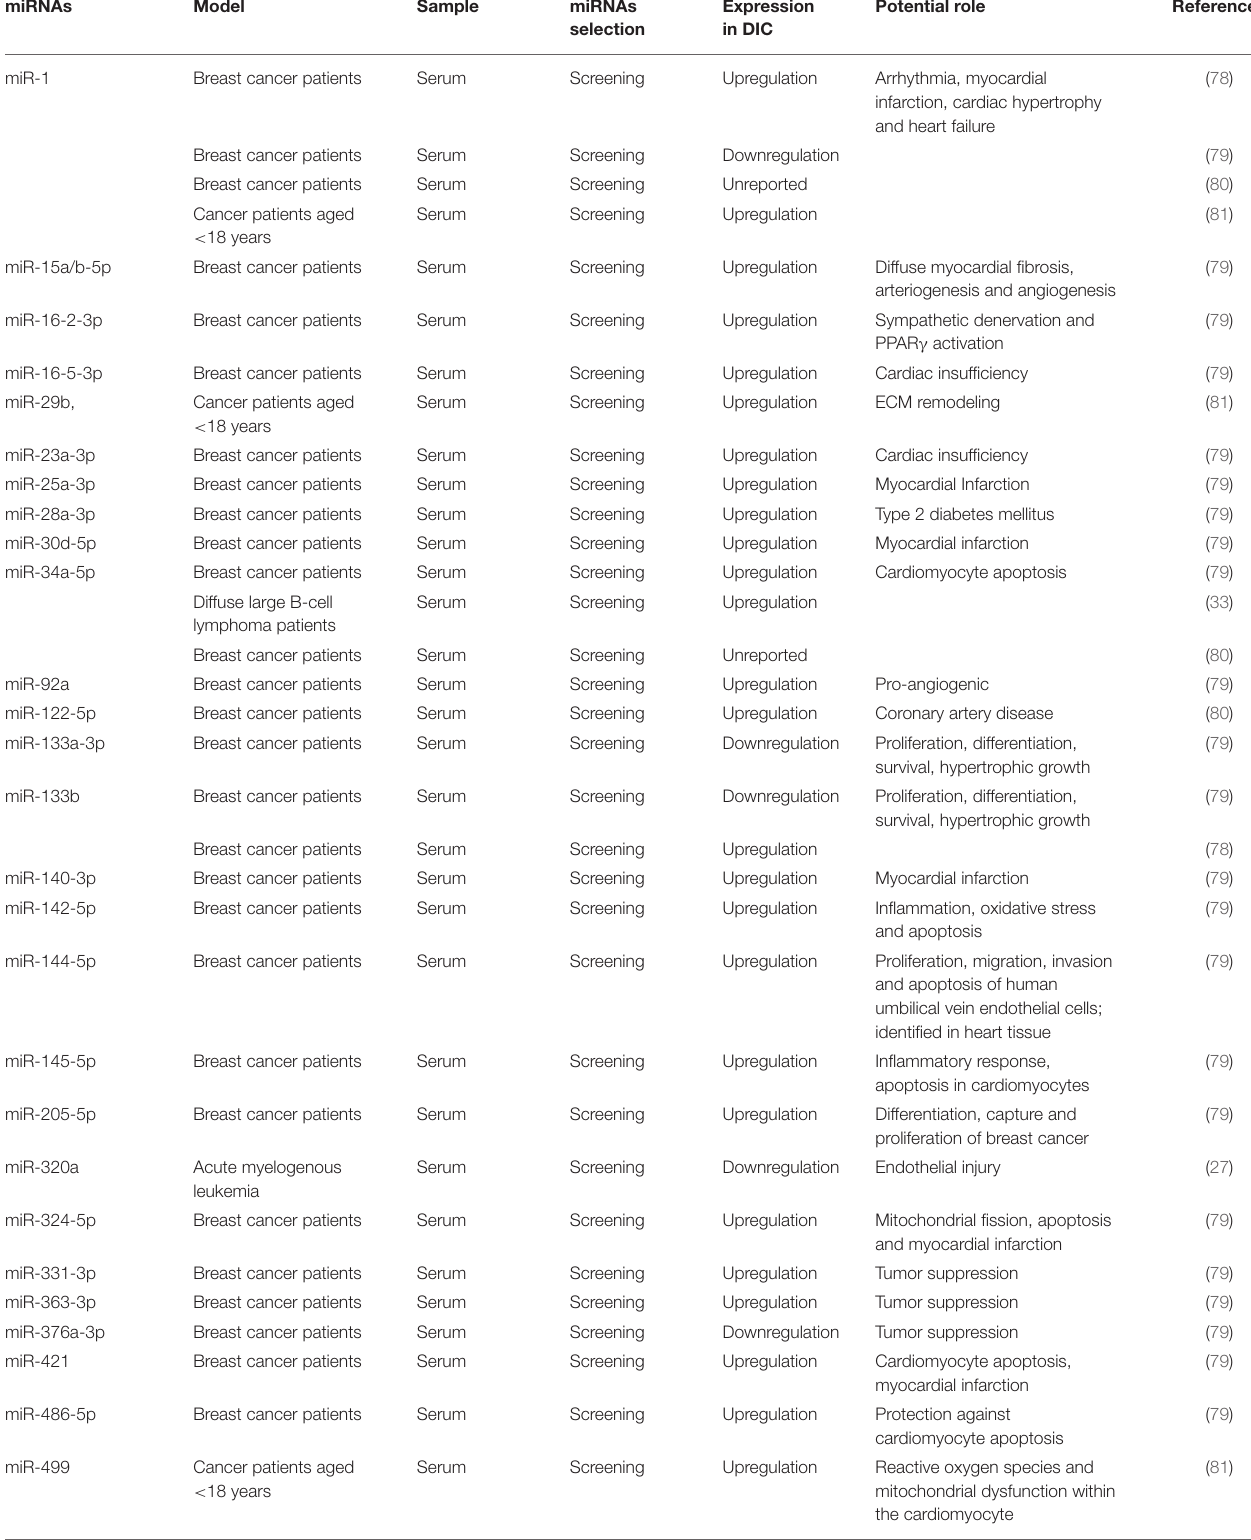
TABLE 2 | Clinical significance of miRNAs in DIC. miRNAs